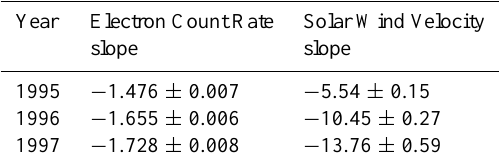
Table 2. Power-law slope values for the electron outer radiation belt count rate data (middle column) and the power-law slope value for the solar wind velocity (right-side column). Adapted from Crosby et al.